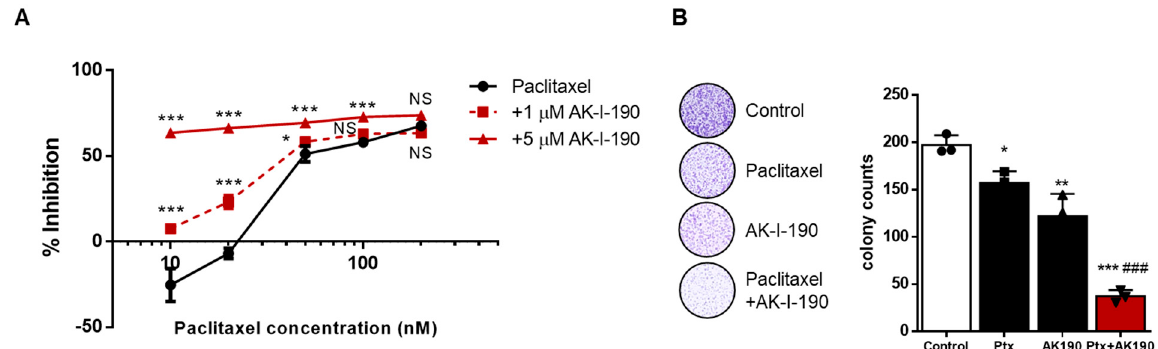
Figure 5. Enhanced anti-proliferative activity of AK-I-190 in combination with paclitaxel. ( A ) DU145 cells were treated with paclitaxel alone or in combination with AK-I-190 for 72 h and cell proliferation was evaluated by WST assay. ( B ) Clonogenic assay was performed with DU145 cells incubated with paclitaxel (1 nM) and/or AK-I-190 (5 µ M) for 10 days. Cells were stained and viable colonies were counted. All determinations were made in 3 replicates in 3 different experiments and the values are mean ± S.D. * p < 0.05, ** p < 0.01, and *** p < 0.001 vs. control; ### p < 0.001 vs. the paclitaxel-treated group.